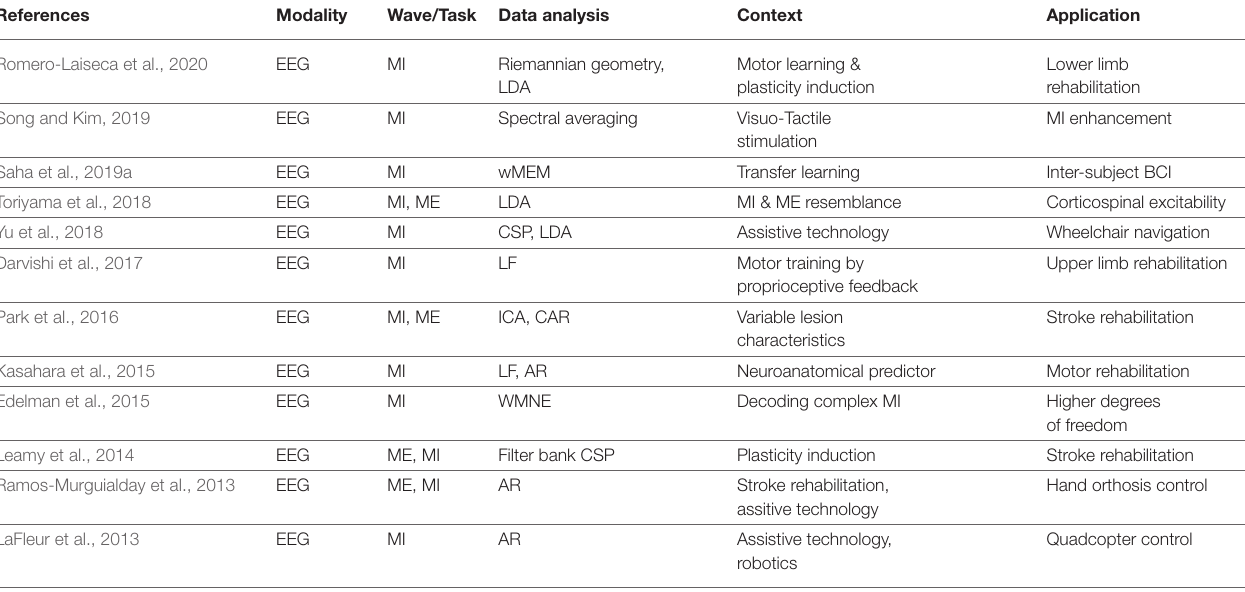
TABLE 2 | A summary of sensorimotor rhythms and electroencephalography-based brain computer interface (BCI) studies.